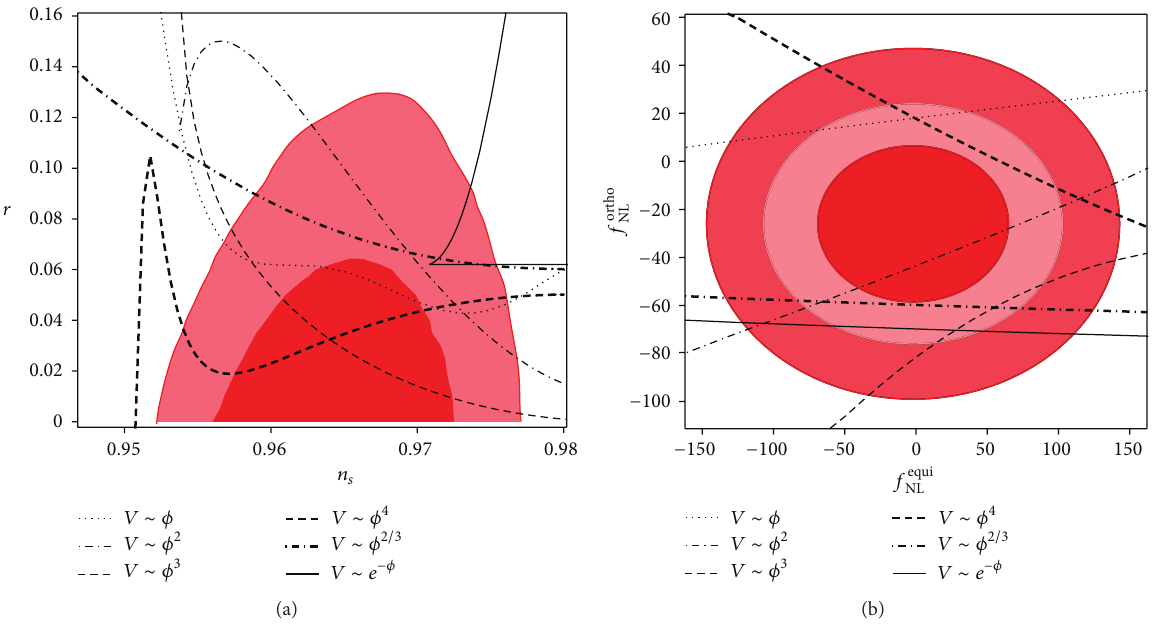
Figure 6: Tensor-to-scalar ratio versus the scalar spectral index for an inflationary model in which both inflaton and its derivative are nonminimally coupled to gravity, in the background of Planck 2015 TT, TE, and EE + lowP data (a) and the amplitude of the orthogonal configuration versus the amplitude of the equilateral configuration of non-Gaussianity for an inflationary model in which both inflaton and its derivative are nonminimally coupled to gravity, in the background of Planck 2015 TTT, EEE, TTE, and EET data (b). Figure is plotted with 𝑛 = 3 , 𝑓(𝜙) ∼ 𝜉𝜙 4 , and various types of potential, for 𝑁 = 60 .